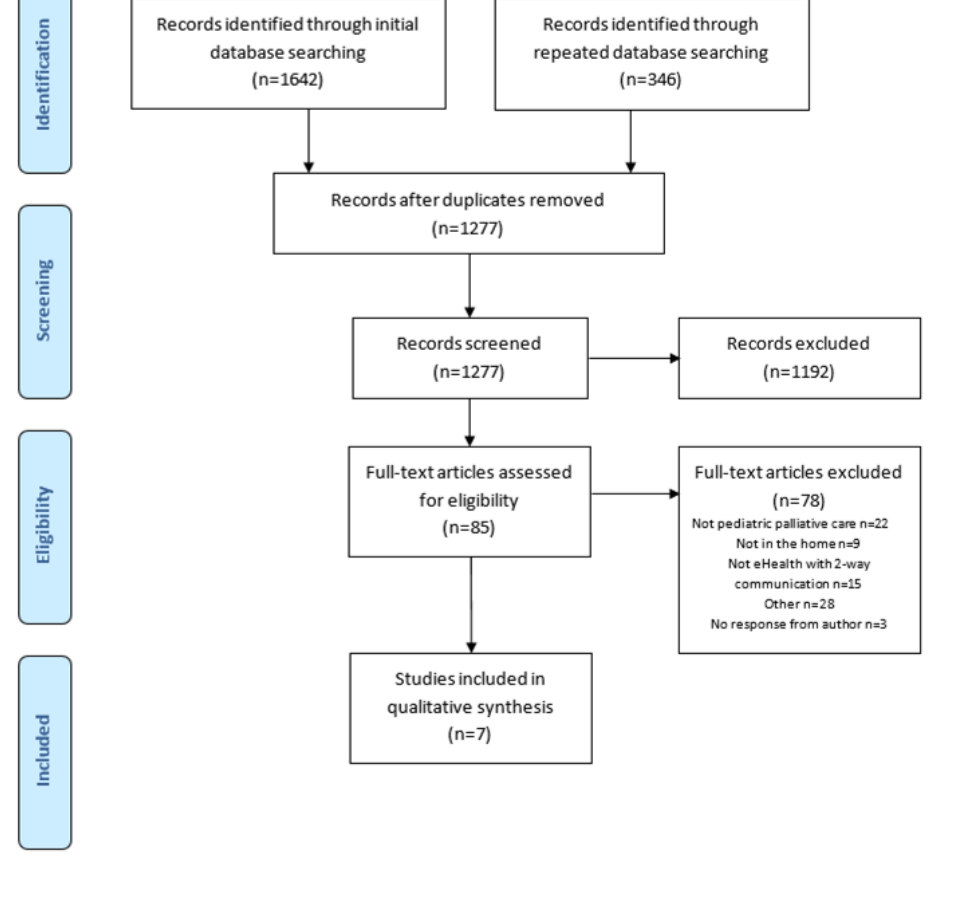
Figure 1. Flow chart of the systematic search